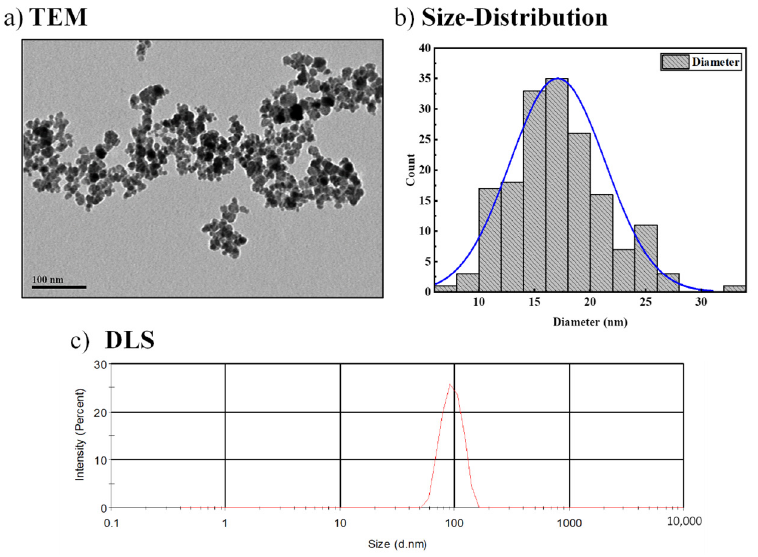
Figure 2. ( a ) TEM image; ( b ) corresponding particle size distribution; and ( c ) hydrodynamic size (D H ) distribution of Fe 3 O 4 -MNP dispersed in water. TEM and HR-TEM images clearly show the highly crystalline nature of the as-synthesized MNPs and their well-defined interfringe spacings.